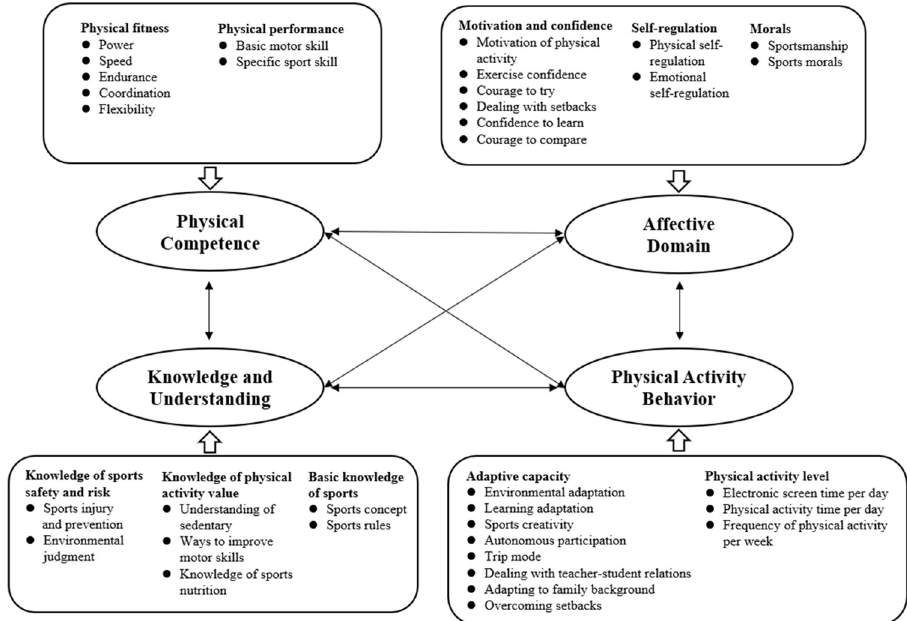
Fig 2. The physical literacy structure model for Chinese students in grade 3–6.